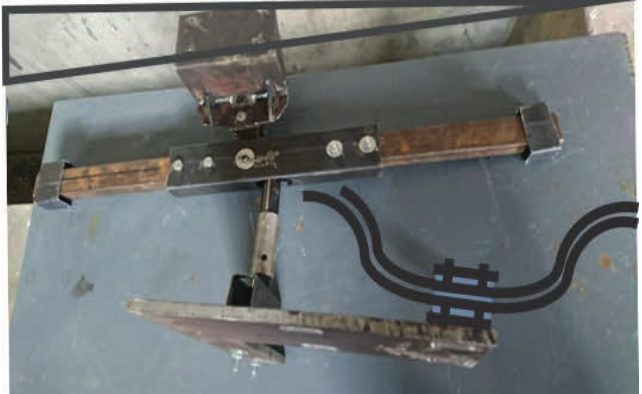
Fig. 4. Test sample: an inertial recuperator of the vehicle suspension with a pendulum unit – separately, with markings to the attachment places on the frame 1 and 2 spring. When passing over the road irregularities, the trajectories of wheels of the vehicle are on the lines of the land contour. On the ascending ridge of the road profile irregularity (Fig. 6), the wheel 5 moves upwards, while due to the large inertial mass of vehicle, the movement of its frame 2 lags behind the movement of wheel 5 and the movement of axle